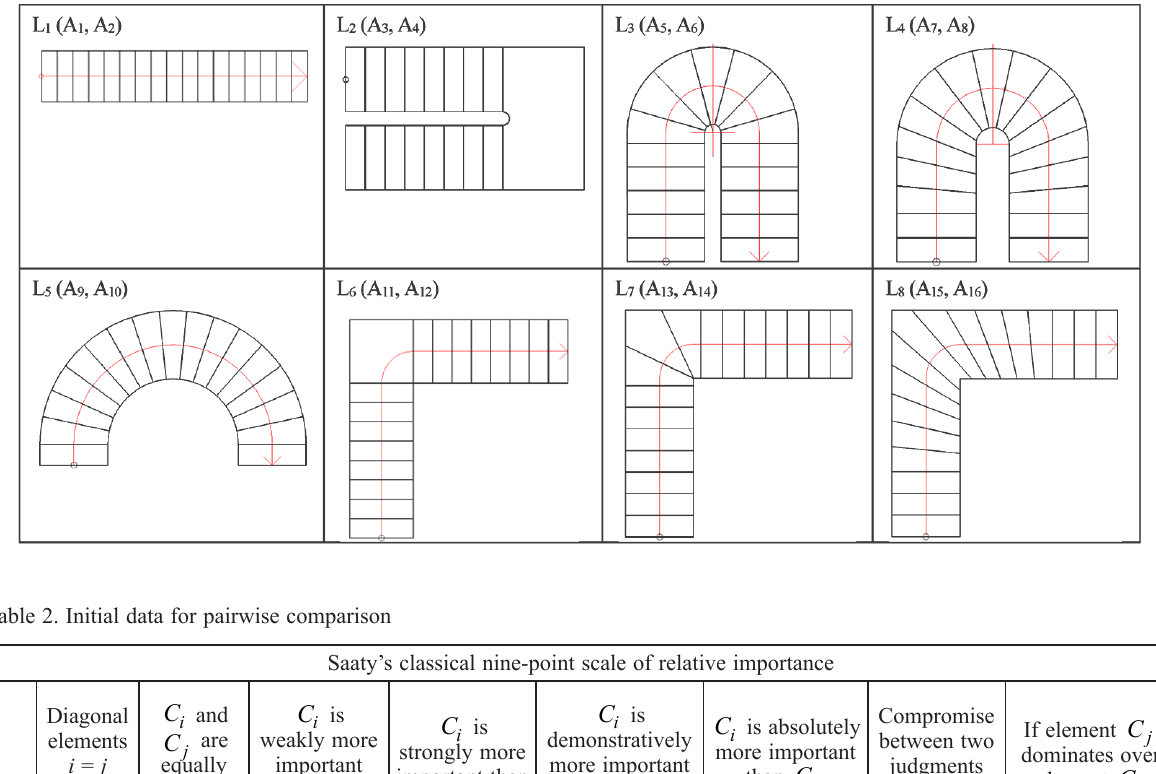
Table 1. Main stair shapes for single flat dwelling houses